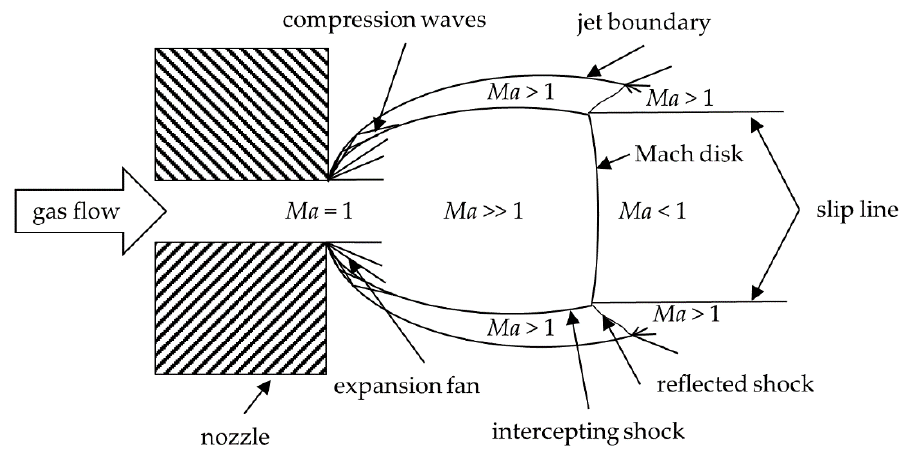
Figure 2. Scheme of a free gas expansion, modified after [13,24]. The gas flow expands in the low-pressure region downstream of the nozzle .